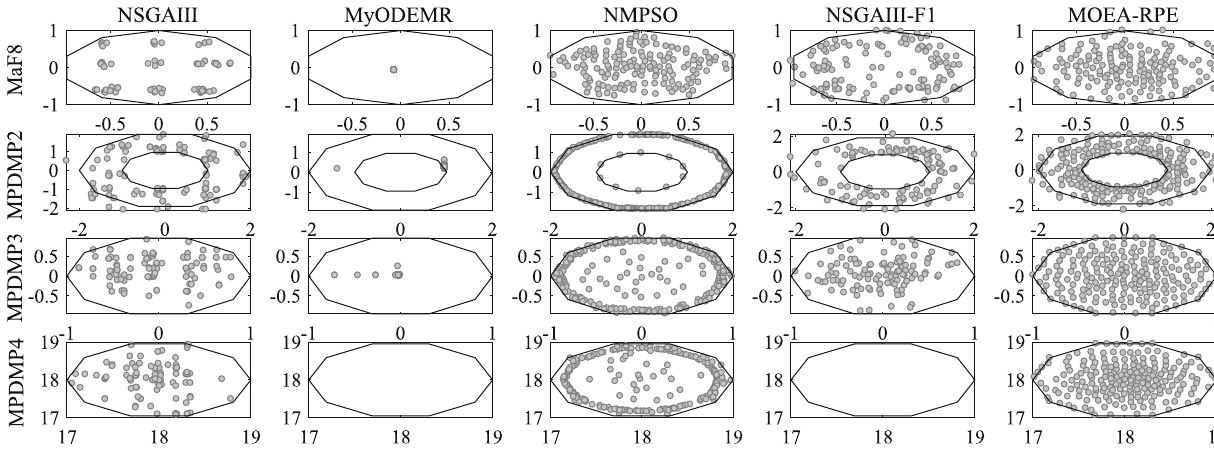
Fig. 7 The distribution of solutions with medium performance on MPDMPs Table 4 The statistical results (mean and standard deviation) in terms of IGD values in the effectiveness study